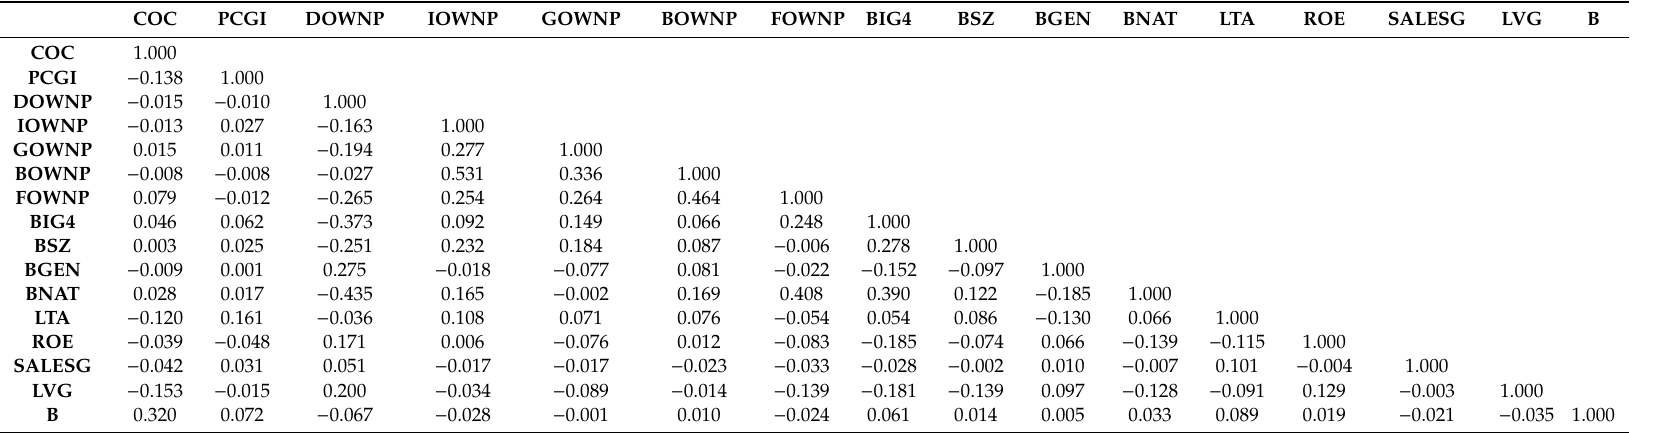
Table A3. Correlation matrix of dependent and independent variables: CG and COC